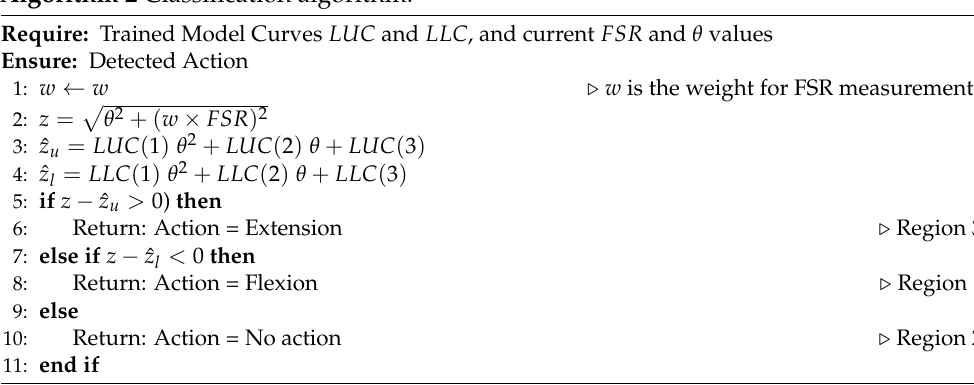
Algorithm 2 Classification